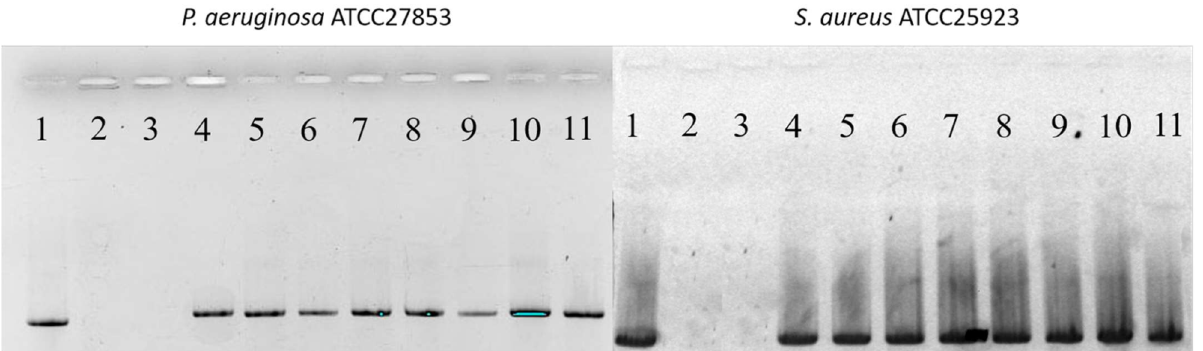
Figure 3. PHMG-Cl inhibits PCR amplification of 16S rDNA target sequences from eDNA released from 5-day-old dehydrated Pseudomonas aeruginosa ATCC 27853 (PA) and Staphylococcus aureus ATCC 25923 (SA) biofilms after treatment with biocides. Shown here are 1.2% agarose-TA gels stained with EtBr to visualize PCR products from PA (left) and SA (right) biofilms after 1 h of exposure to biocides. Treatments: (1) water-only control, (2) 0.1% PHMG-Cl, (3) 0.05% PHMG-Cl, (4) 6% hydrogen peroxide, (5) 3% hydrogen peroxide, (6) 70% ethanol, (7) 0.05% chlorhexidine, (8) 0.25% Maxisan,